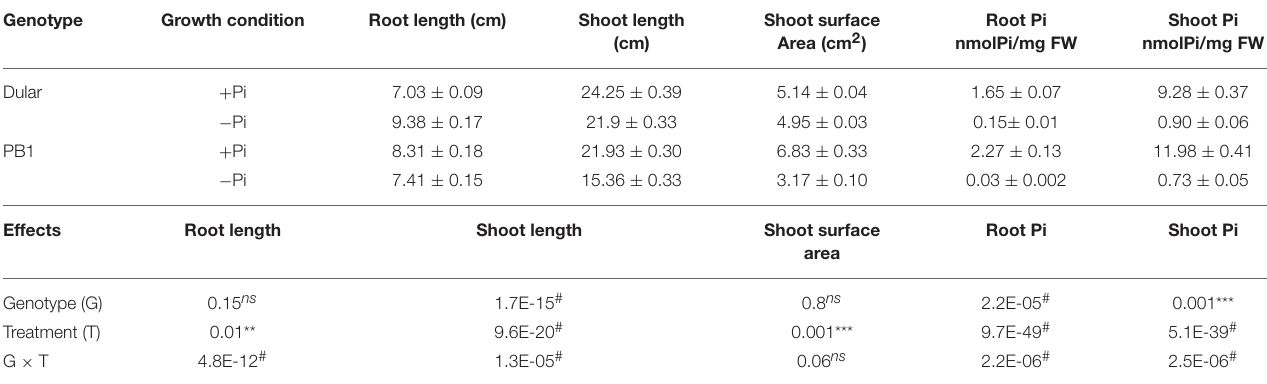
TABLE 1 | Plant growth and Pi accumulation in Dular and PB1.